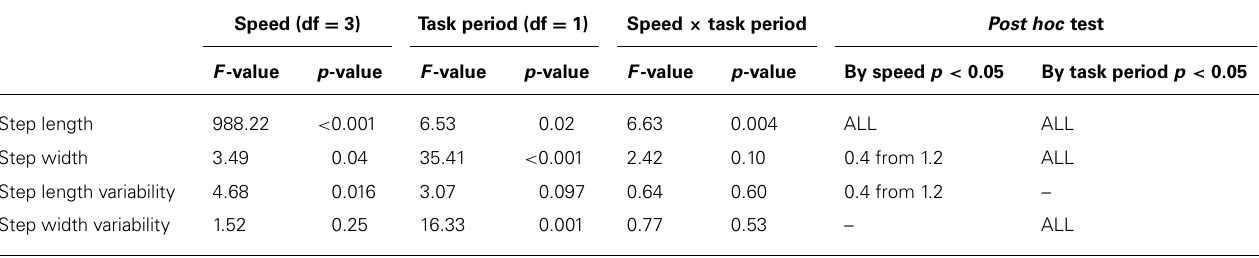
Table 3 |ANOVA table showing F and p -values for speed, task period, and speed × task period interaction. Speed (df = 3)